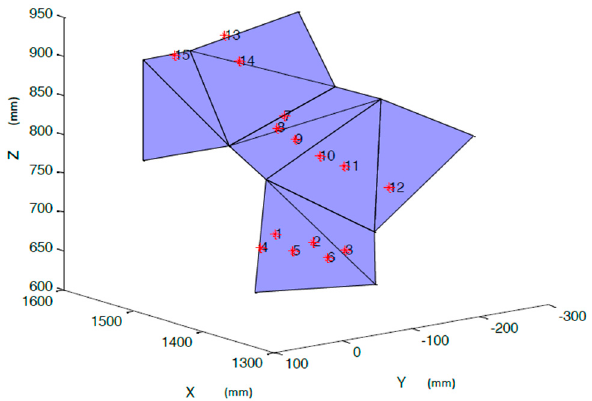
Figure 3. Simplified triangles for white body weld piece, red spots: weld joints.